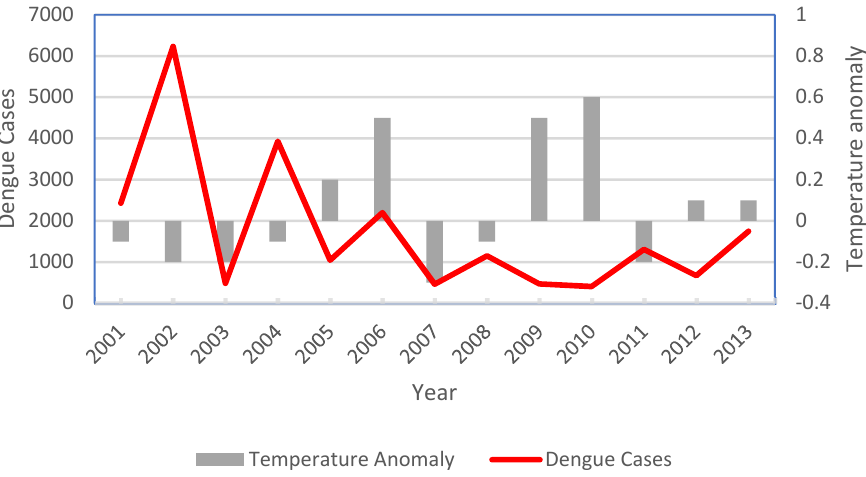
Figure 5. Distribution of temperature anomaly vs. dengue cases in the city of Dhaka, Bangladesh for the 13-year study period (2001–2013).